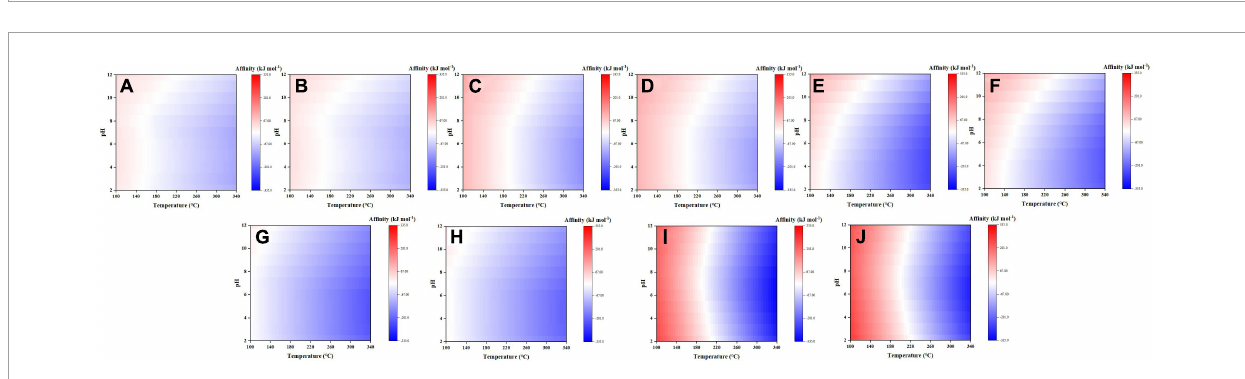
FIGURE5 Synthesis affinity of glycine (A,B) , alanine (C,D) , aspartic acid (E,F) , serine (G,H) , and lysine (I,J) using CO, g (A,C,E,G,I) and CO 2 , g (B,D,F,H,J) as the carbon source.